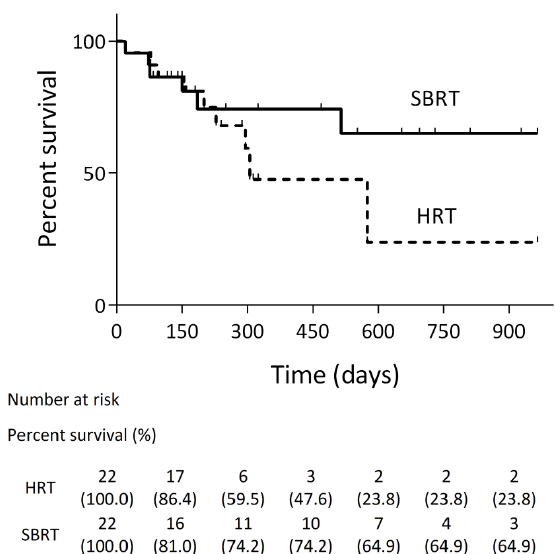
Figure 1. Survival curves. Survival analysis stratified by the type of radiotherapy treatment, plotted as the proportion of patients surviving from the date of treatment versus time in days using the Kaplan- Meier method. Below the graph, the table indicates the number of patients at risk and the percentage of survival for each treatment versus time elapsed since